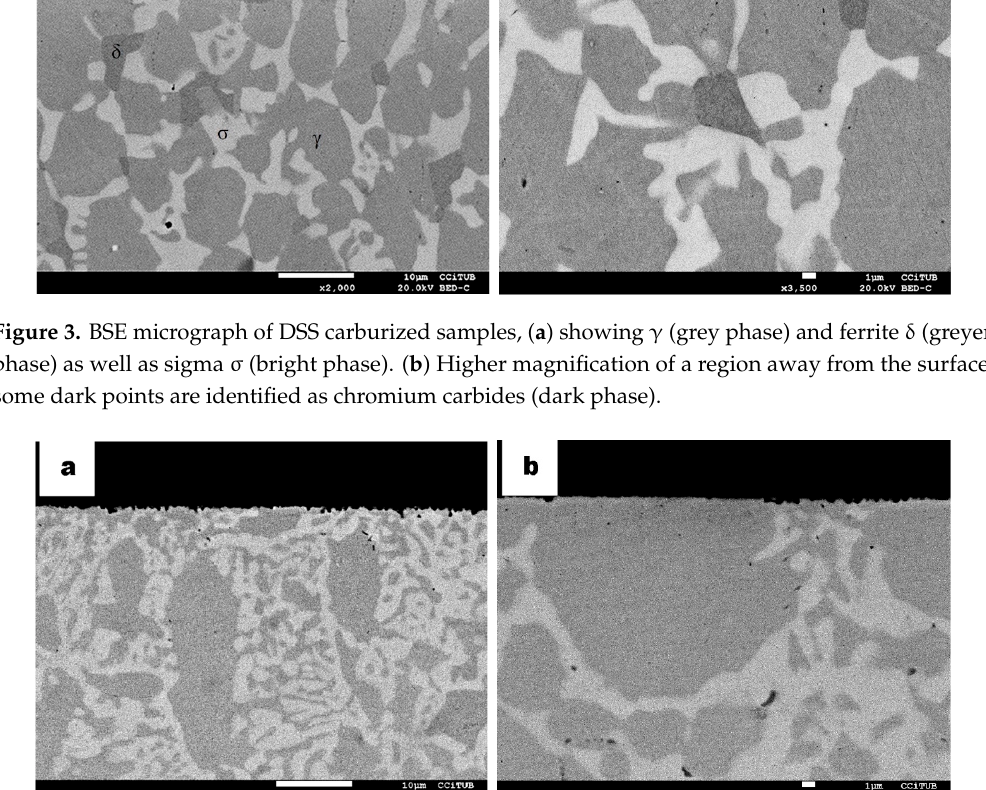
Figure 4. BSE micrograph of SDSS carburized samples ( a ) indicating γ (grey phase), sigma phase σ (bright phase) and chromium carbides (dark phase); ( b ) higher magnification of an area at the surface.